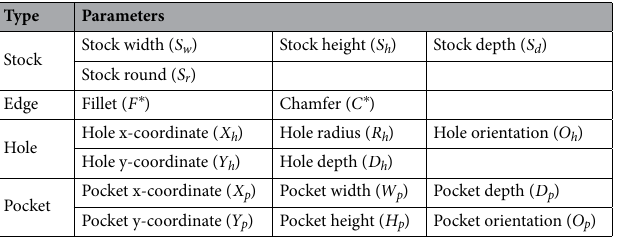
Table 2. Parameters used to control the shape of a 3D CAD model. *Means Boolean parameter.